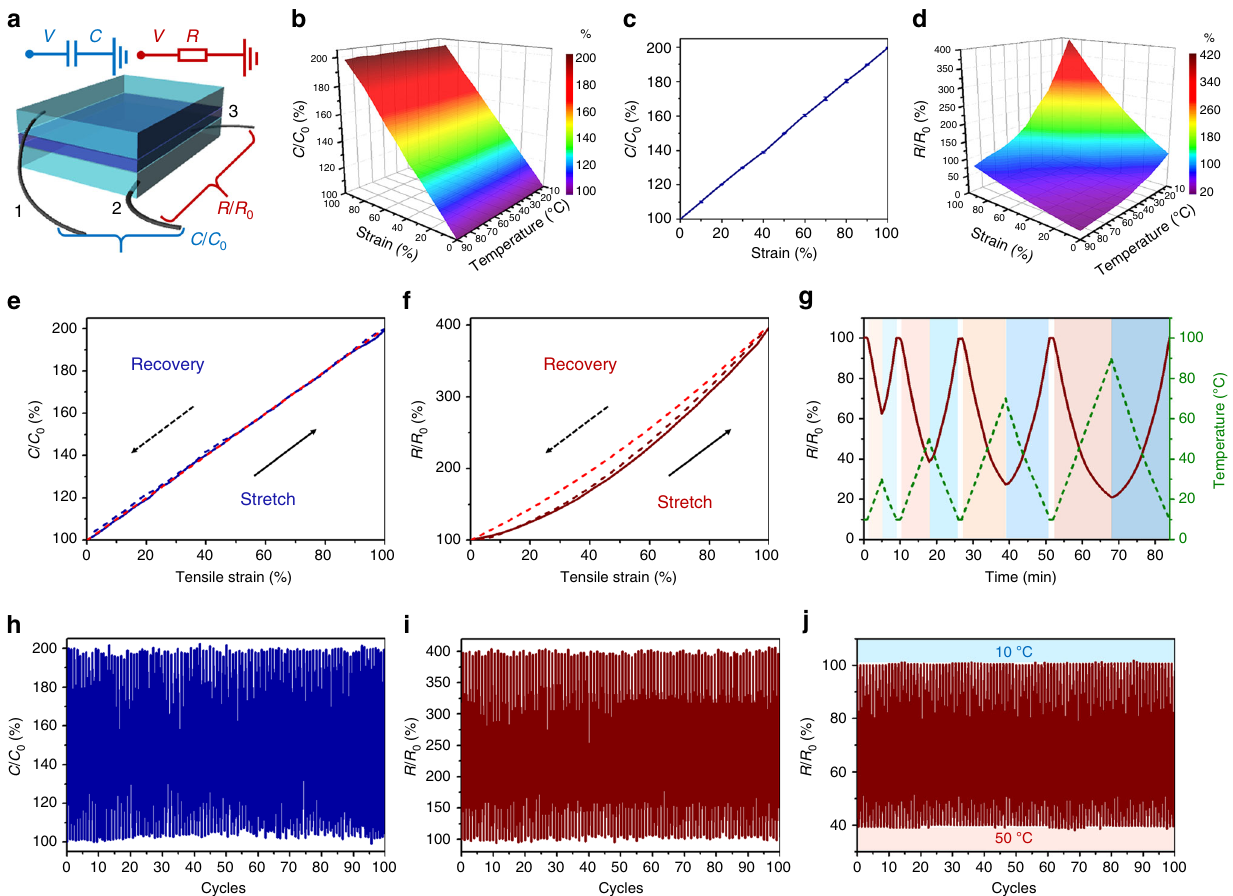
Fig. 3 Strain and temperature sensations of the biomimetic skin. a Schematic design and two simpli fi ed equivalent electrical circuits of the biomimetic skin. b The capacitive response of the biomimetic skin upon mutual effect of strain and temperature. c The capacitance – strain curve of the biomimetic skin. Data are derived from average values of capacitance at different temperatures in b , and error bars (standard deviations) are very small suggesting the capacitive response is insensitive to temperature variation. d The resistive response of the biomimetic skin upon mutual effect of strain and temperature. e The reversible capacitance – strain curves and the theoretical prediction (red dash line). f The reversible resistance – strain curves and the theoretical prediction (red dash line). g The reversible resistance – temperature curves. h Capacitance – strain cycling curves in the strain range of 0 – 100%. i Resistance – strain cycling curves in the strain range of 0 – 100%. j Resistance – temperature cycling curves in the temperature range of 10 – 50 Movie 1 records the hydrogel ’ s wide spectrum of mechanical properties in real time. It not only shows elastic resilience under fi nger presses and extremely high stretchability but is also able to recon fi gure its shapes and heal cracks very fast.